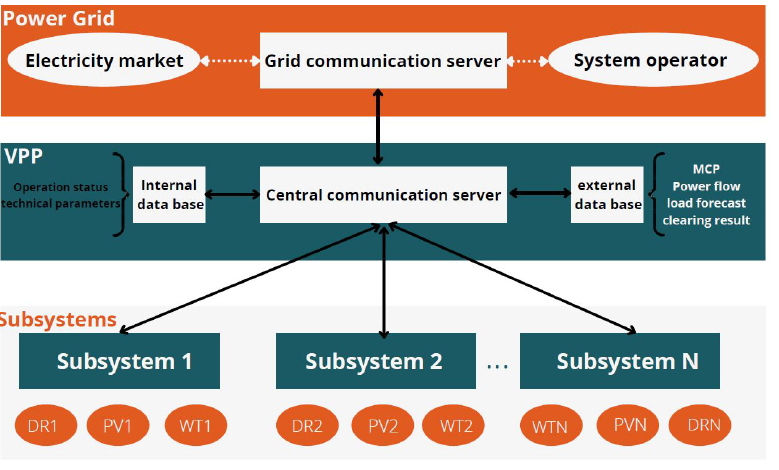
Figure 4. VPP distributed